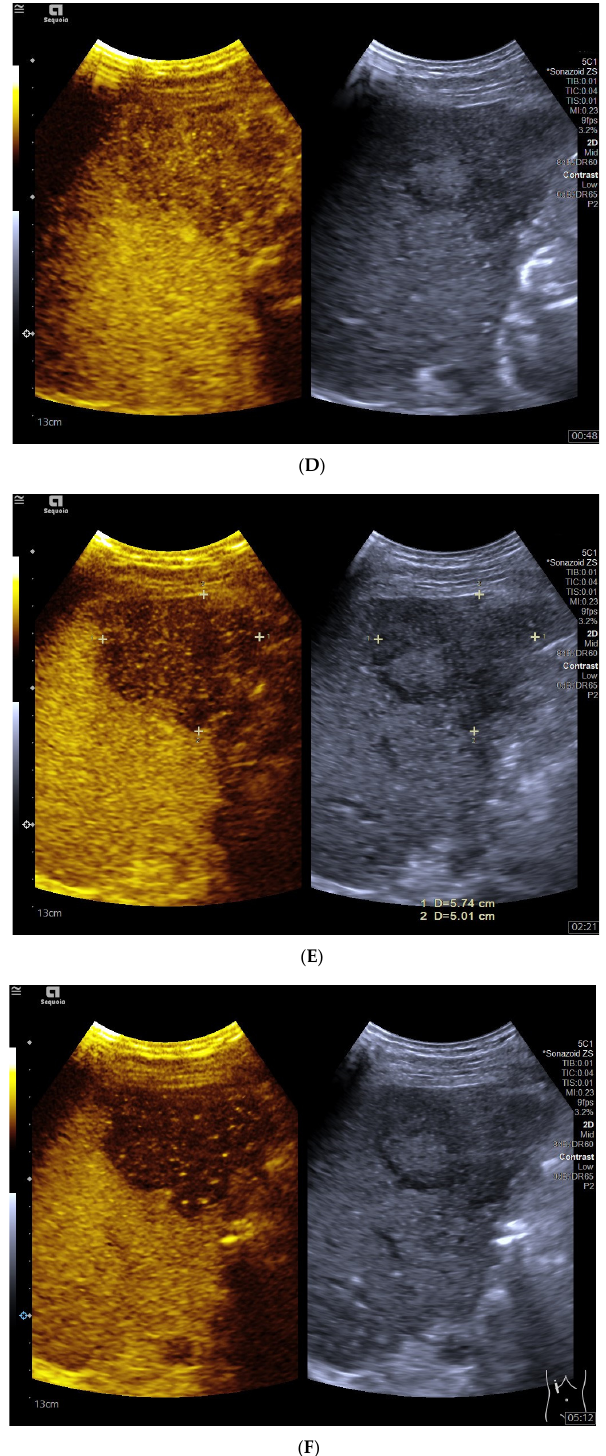
Figure 1. Hepatocellular carcinoma in the non-cirrhotic liver in a 65-year-old male patient. B-mode ultrasound (BMUS) displayed a hyperechoic focal liver lesion in the right lobe of the non-cirrhotic liver, with an ill-defined margin and irregular shape ( A ). Dotted color flow signals could be detected inside the lesion ( B ). On Sonazoid-enhanced contrast-enhanced ultrasound (CEUS), the lesion showed heterogeneous hyperenhancement during the arterial phase ( C ) and relatively early washout (23 s after the injection of Sonazoid). The lesion showed hypoenhancement during the portal venous phase ( D ), late phase ( E ), and Kupffer phase ( F ).